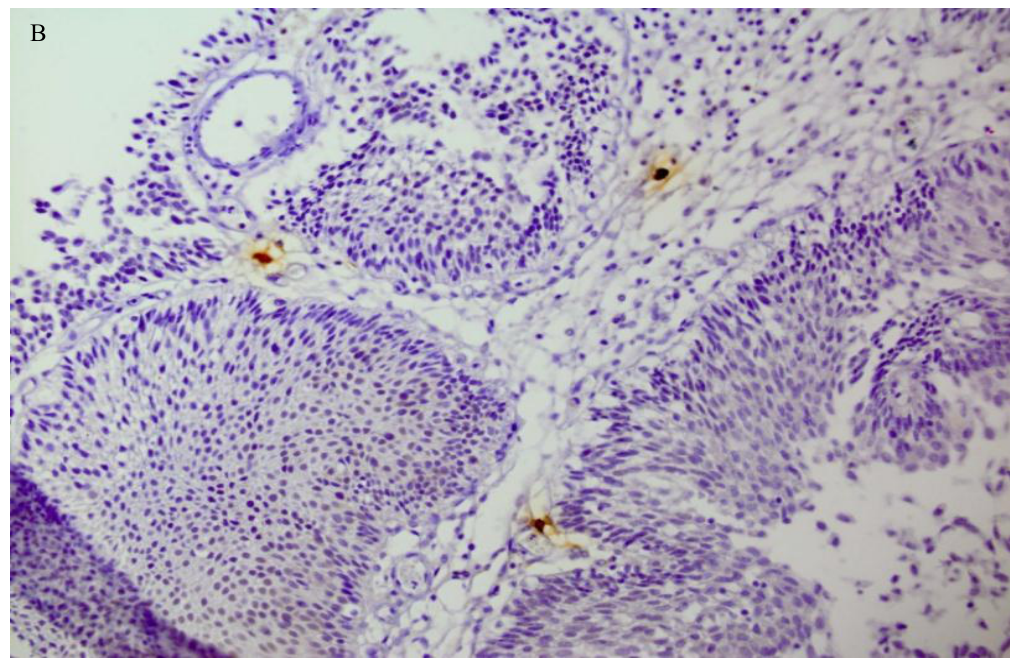
Fig. 1. A and B: (X10, X20 magnification, respectively) Low-grade TCC (transitional cell carcinoma) stained by mast cell tryptase, highlighting mast